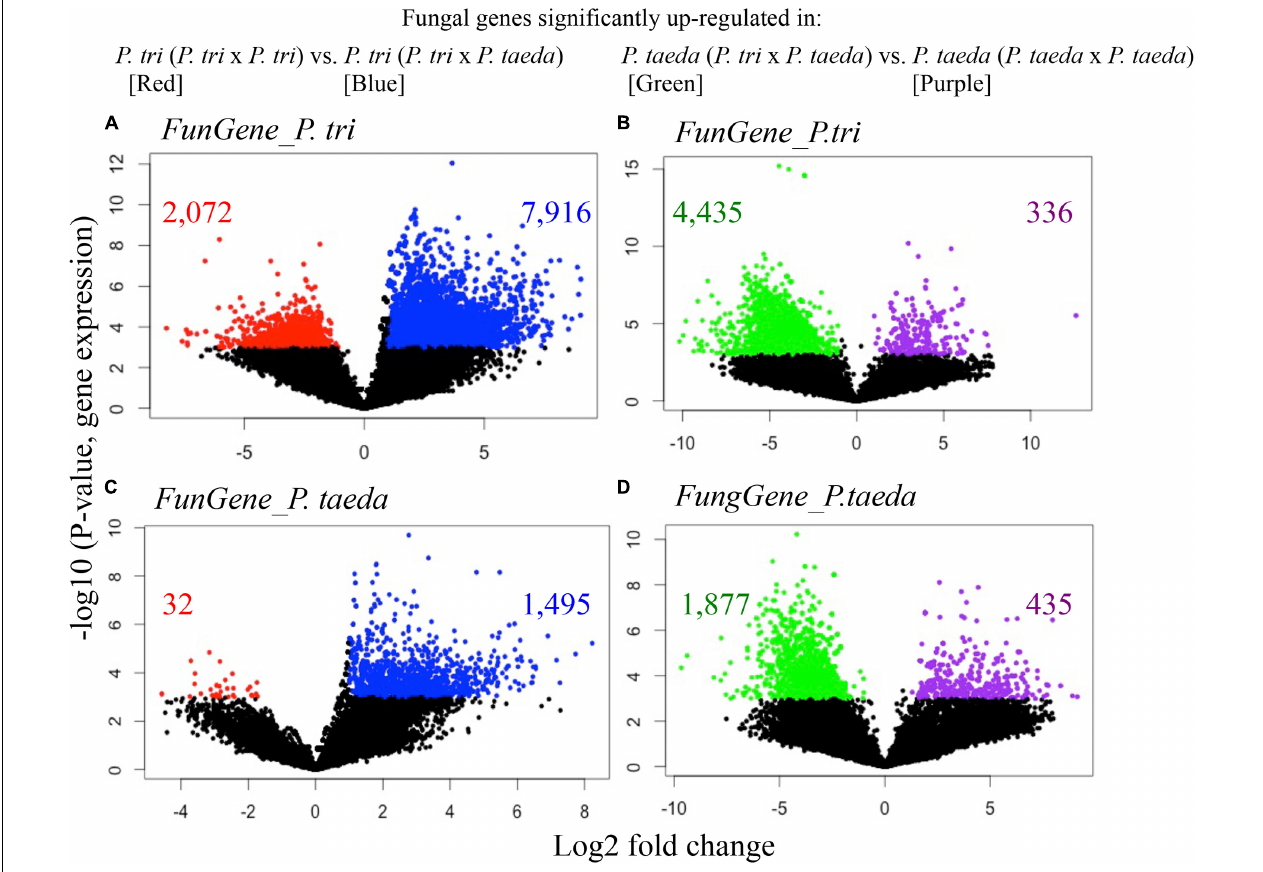
FIGURE 5 | Volcano plots show the expression of fungal genes originally expressed in Populus trichocarpa roots ( FunGene_P. tri , A,B ) in Pinus taeda roots ( FunGene_P. taeda , C,D ) in response to neighbor plant species. (A) FunGene_P. tri on P. trichocarpa roots that were up-regulated (in blue) or down-regulated (in red) when grown with P. taeda compared to with P. trichocarpa ; (B) FunGene_P. tri on P. taeda roots that were up-regulated (in green) or down-regulated (in purple) when P. taeda was grown with P. trichocarpa compared to with P. taeda. (C) FunGene_P. taeda on P. trichocarpa roots that were up-regulated (in blue) or down-regulated (in red) when grown with P. taeda compared to when grown with P. trichocarpa ; (D) FunGene_P. taeda on P. taeda roots that were up-regulated (in green) or down-regulated (in purple) when P. taeda was grown with P. trichocarpa compared to when grown with P. taeda. Data of loading gene factors were generated using coordinate scales on the left (log10 of expression rate) and the bottom (mean of log2-fold changes). Cross-comparative expression of the genes was analyzed using t -test to compare the fungal genes of the roots from a plant species grown with conspecific vs. heterospecific neighbors ( n ≥ 3; Wilcox.Test P < 0.01; FDR < 0.05; fold changes ≥ 2). The total counts of genes detected and significant changes in gene counts in response to neighbor effects are listed in Supplementary Dataset 3